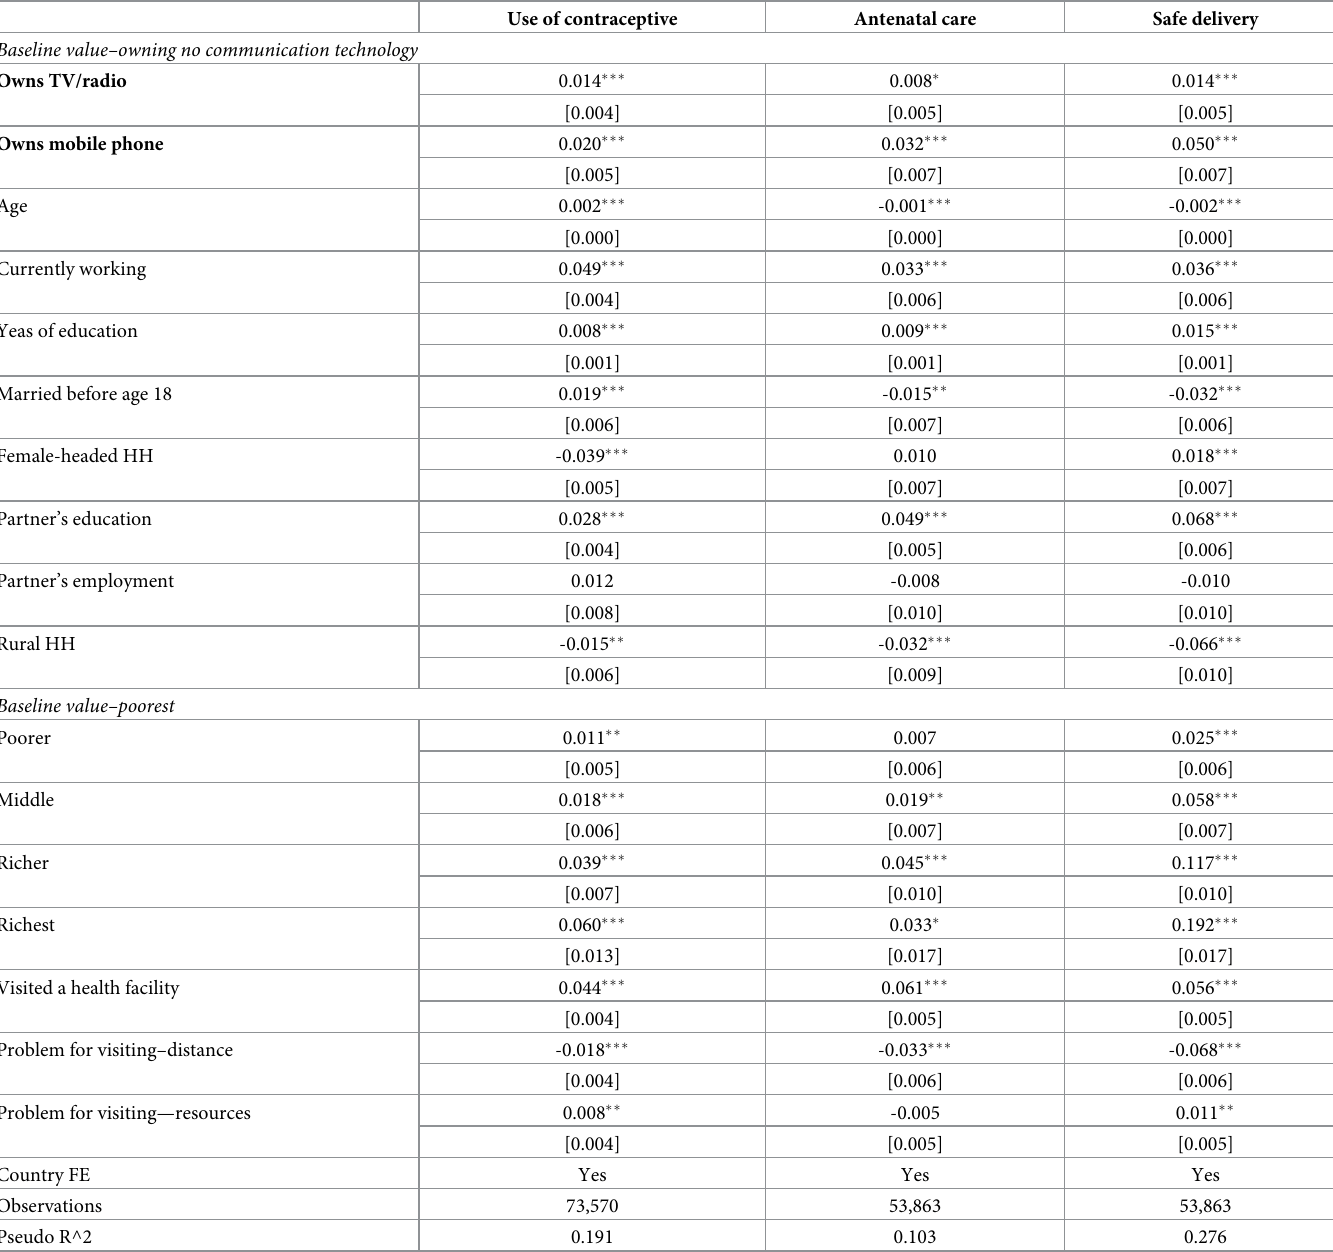
Table 2. Estimated marginal effects of communication technology on the use of contraceptives, antenatal care and safe